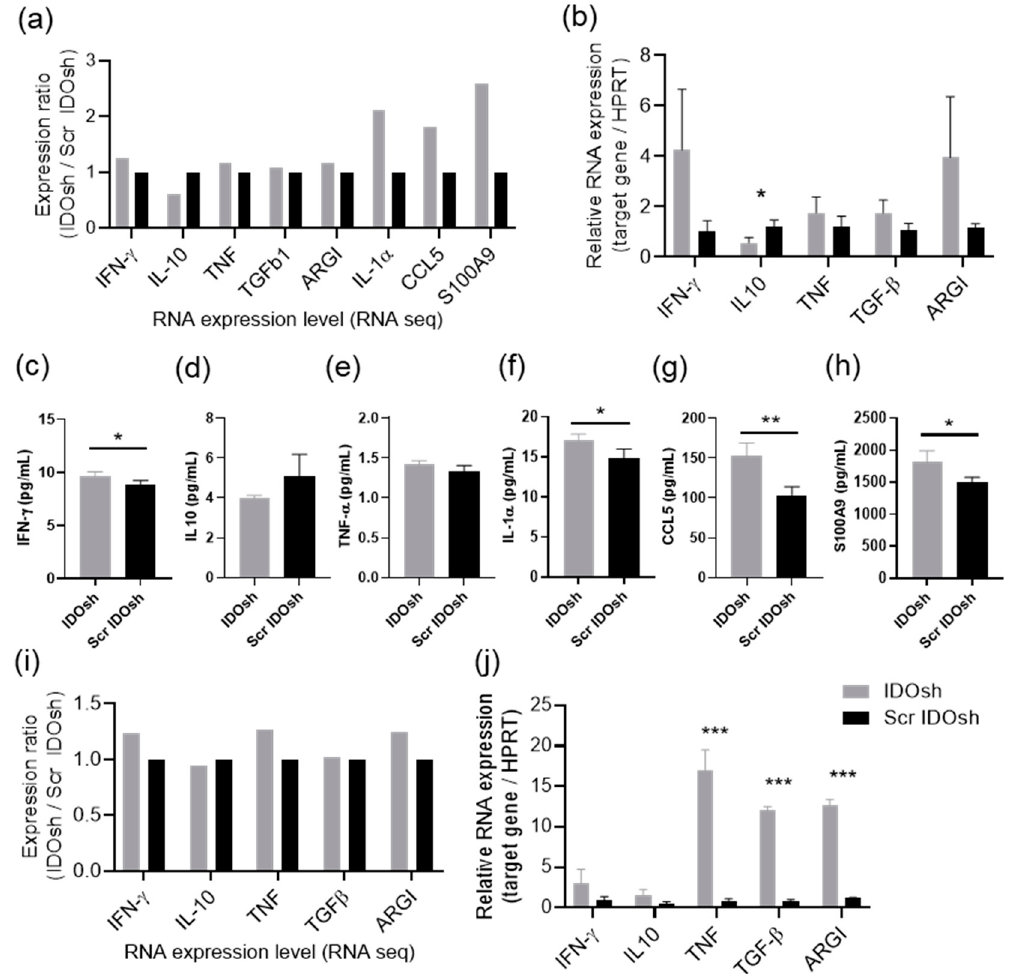
Figure 2. The expression of inflammatory molecules. ( a ) The expression of inflammatory molecules of total splenocytes, determined by RNA sequencing and ( b ) by QPCR. To detect the secreted protein levels, splenocytes were collected at 16 days after LLC1 injection. After 24-h culture, these molecules were detected by magnetic fluorescence microsphere immunoassay (MAGPIX) analysis. The expression of ( c ) IFN- γ , ( d ) IL-10, ( e ) TNF- α , ( f ) IL-1 α , ( g ) CCL5, and ( h ) S100A9 was shown. ( i ) The expression of inflammatory molecules of splenic neutrophils determined by RNA sequencing and ( j ) by QPCR. *, **, and *** A statistically significant difference when compared with scramble IDO shRNA group (* p < 0.05; ** p < 0.01; *** p < 0.001). n = 3-4 in each experiment, except to RNA sequencing data. IFN- γ , interferon- γ ; IL-10, interlukein-10; TNF- α , tumor necrosis factor- α ; TGF- β , tumor transforming growth factor- β ; CCL5, CC chemokine ligand 5; S100A9, S100 calcium-binding protein A9; Arg1, arginase 1.